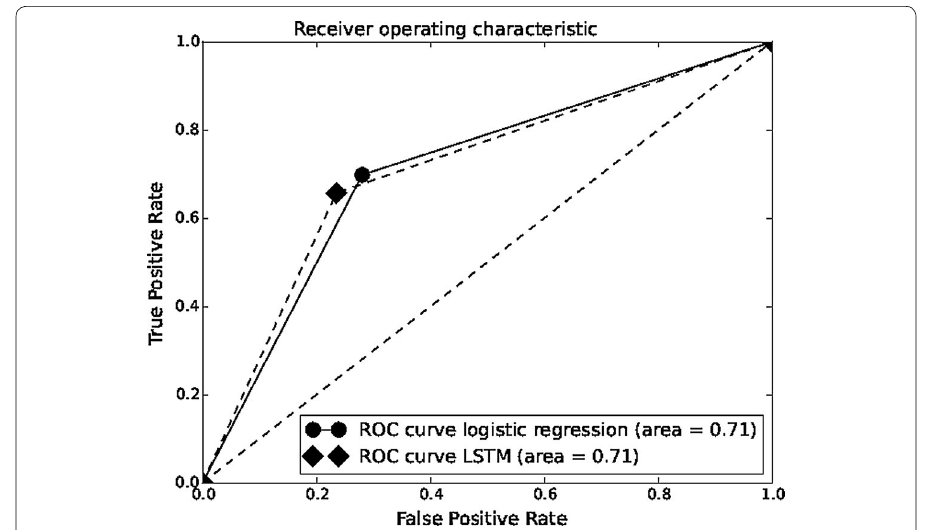
Fig. 6 Area under the ROC curve for long short-term memory